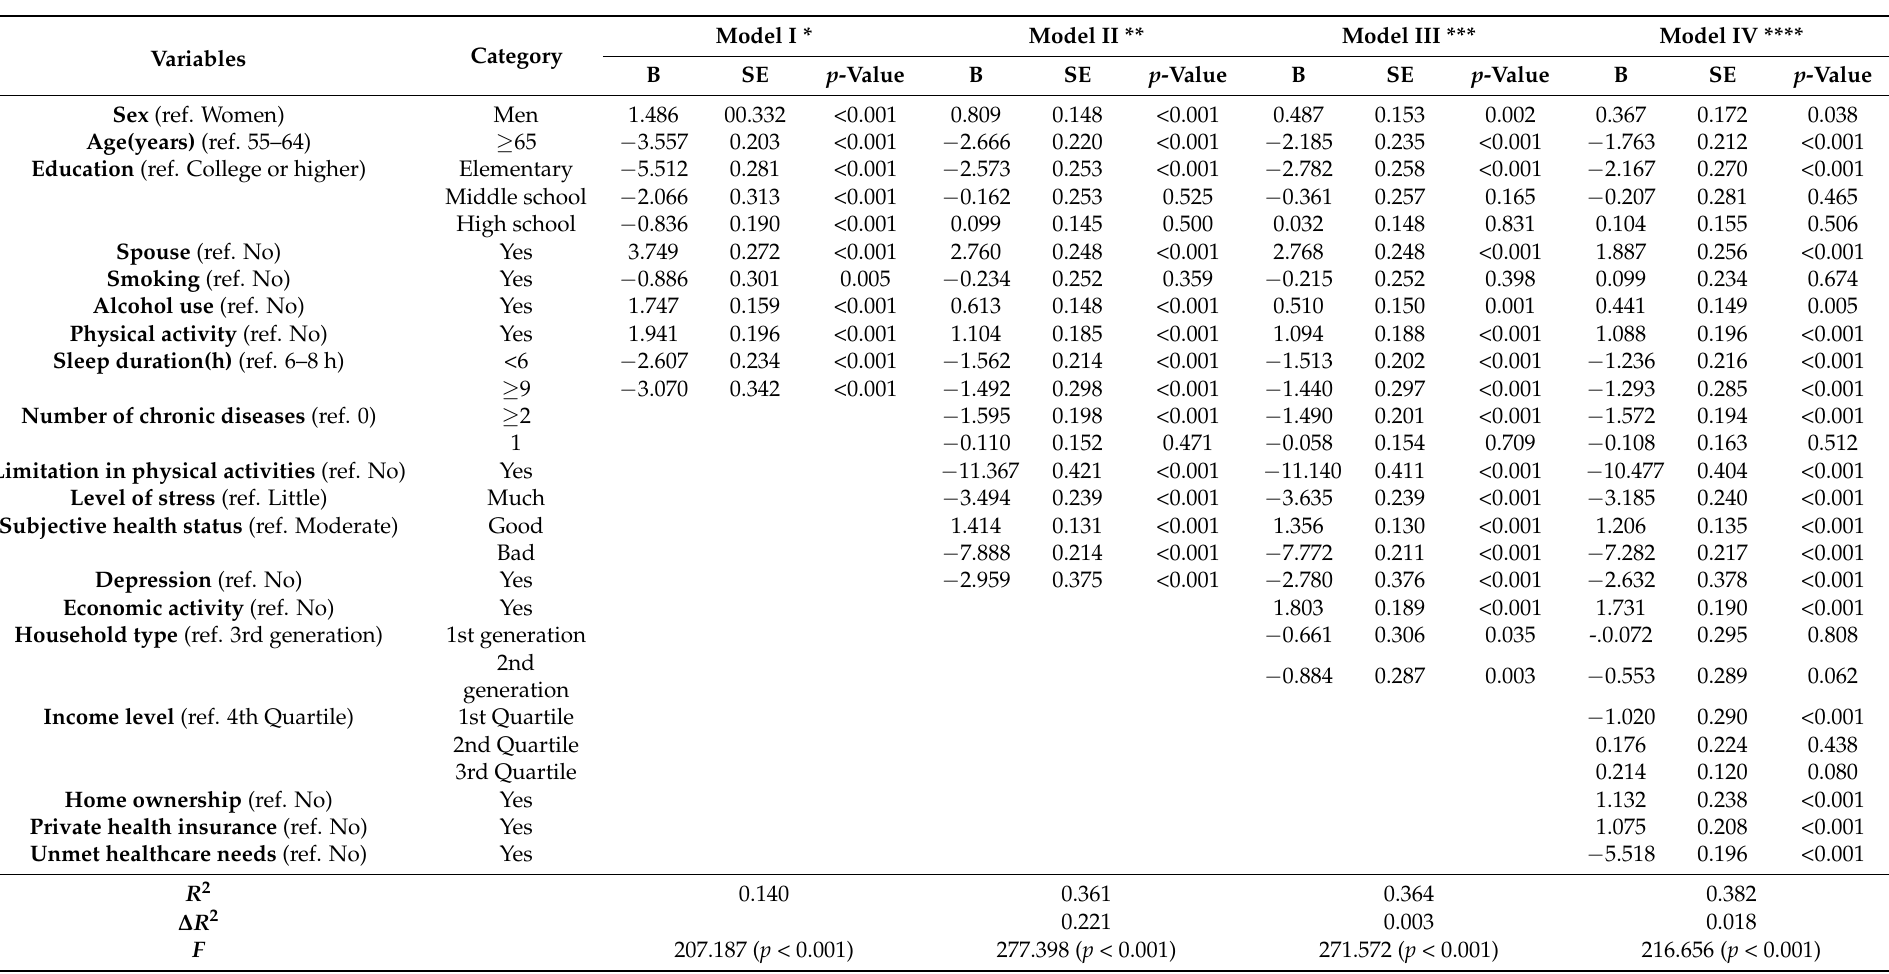
Table 4. Active aging factors affecting health-related quality of